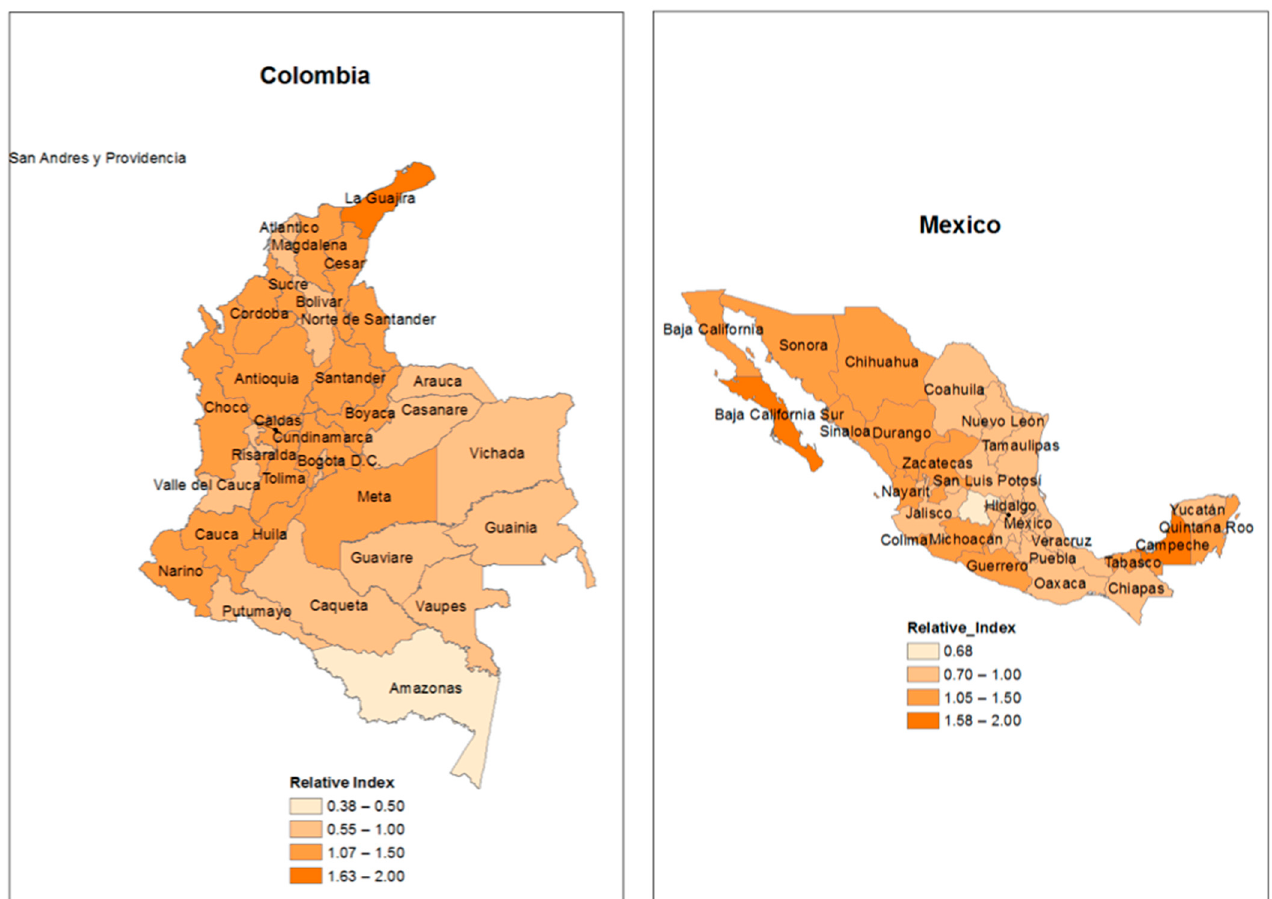
Figure 5. Regional index of CO 2 -based polluting intensity (by regional source). Note: The maps of the four analyzed countries are presented, with the regional aggregation adopted in the study. The upper left map refers to the Brazilian states, the upper right to the Chilean regions, the lower left to the Colombian departments, and the lower right to the Mexican states.